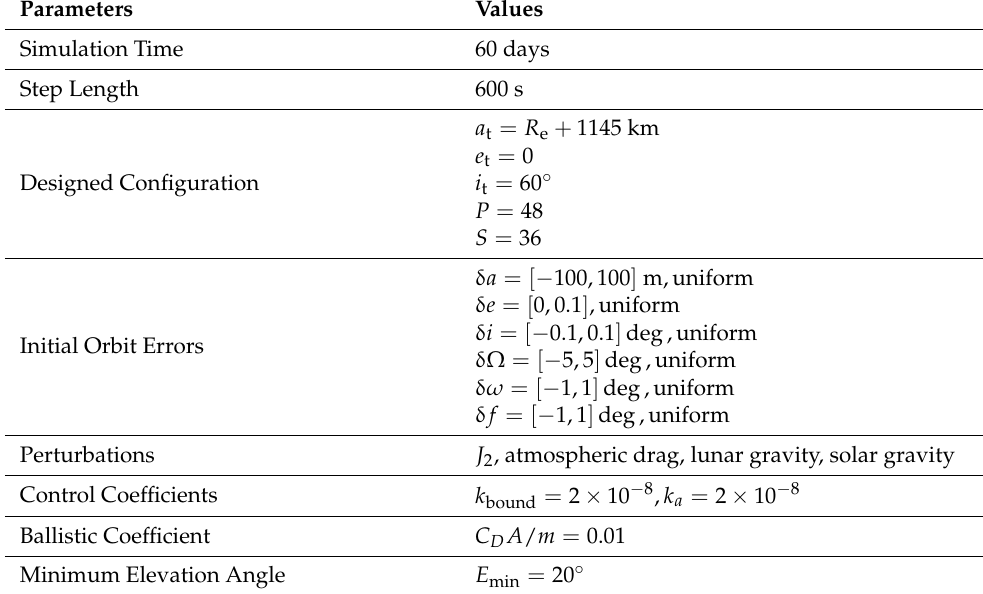
Table 4. Simulation parameters for the mega-constellation case.